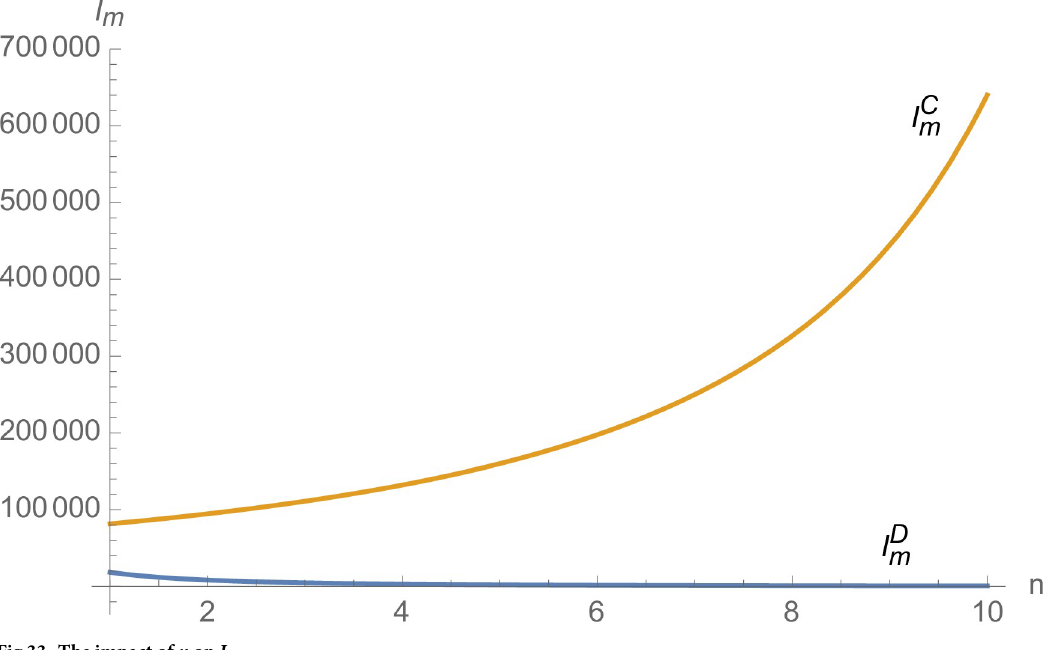
Fig 33. The impact of n on I